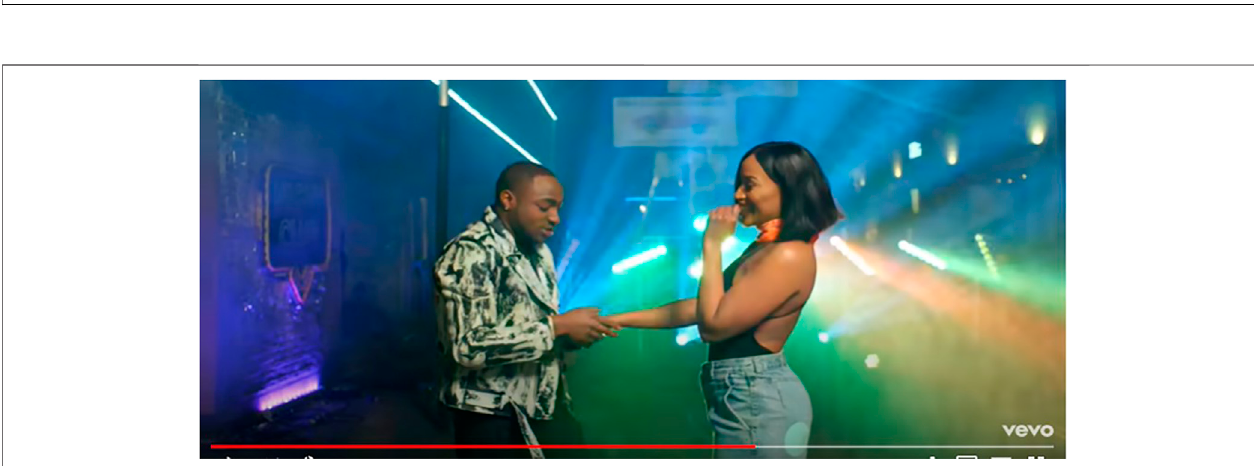
FIGURE2| VisualdisplayofheterosexualromanticrelationsinDavido ’ s “ If ” musicvideo[screenshottakenfrom If(Of fi cialMusicVideo): https://www.youtube.com/ watch?v (cid:1) helEv0kGHd4].